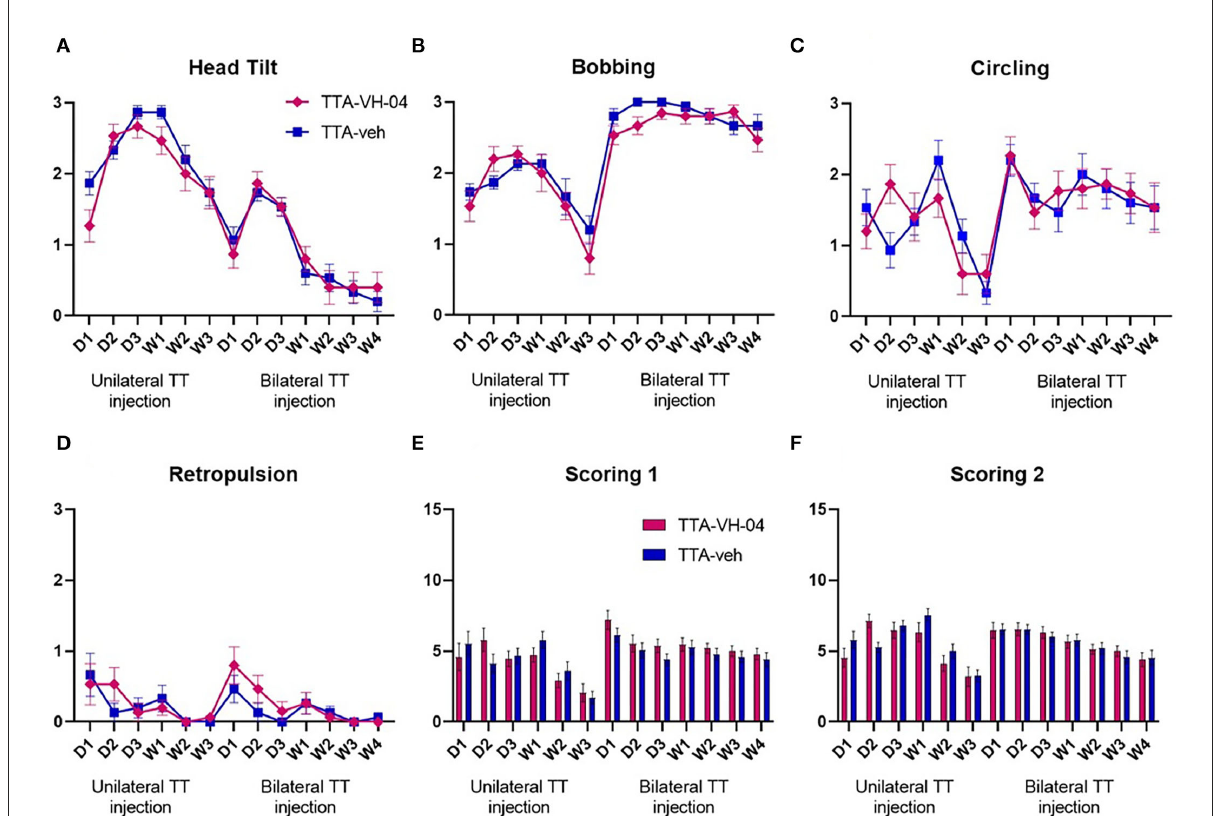
FIGURE4 Illustration of the time course of behavioral subjective evaluation score of each symptom: Head tilt (A) , Bobbing (B) , Circling (C) , and Retropulsion (D) . Illustration of the time course of behavioral subjective evaluation score involving all symptoms with two different scoring scales (E,F) . Data represent mean ± SEM; no statistically significant differences between groups, and two-way ANOVA applies to all graphs. TTA-veh and TTA-VH-04, n =